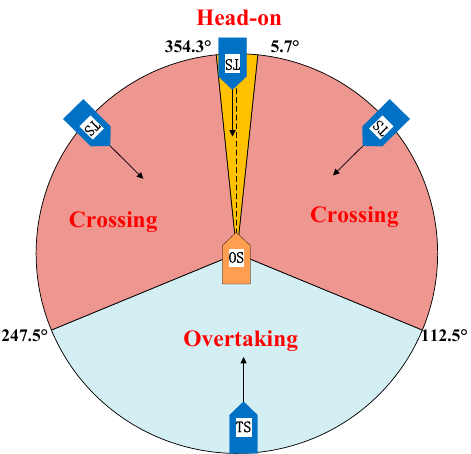
Figure 2. The typical diagram of different encounter situations.